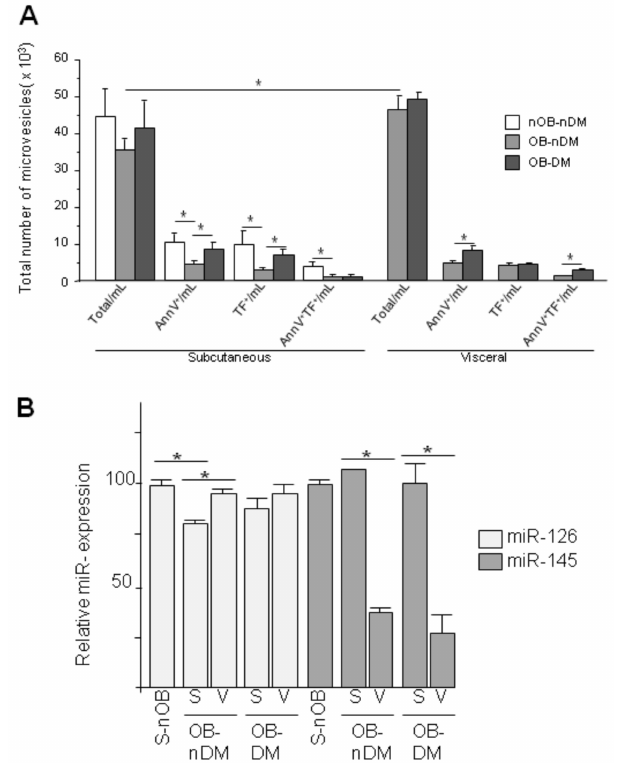
Figure 6. ( A ) ASC microvesicles (MVs) secretion. Influence of obesity and diabetes on ASC derived MVs. Number of MVs measured by flow cytometry (Total, annexin-V positive, TF positive and annexin-V / TF positive MVs); ( B ) miR126 and miR145 relative gene expression in S-MVs and V-MVs. (* p <